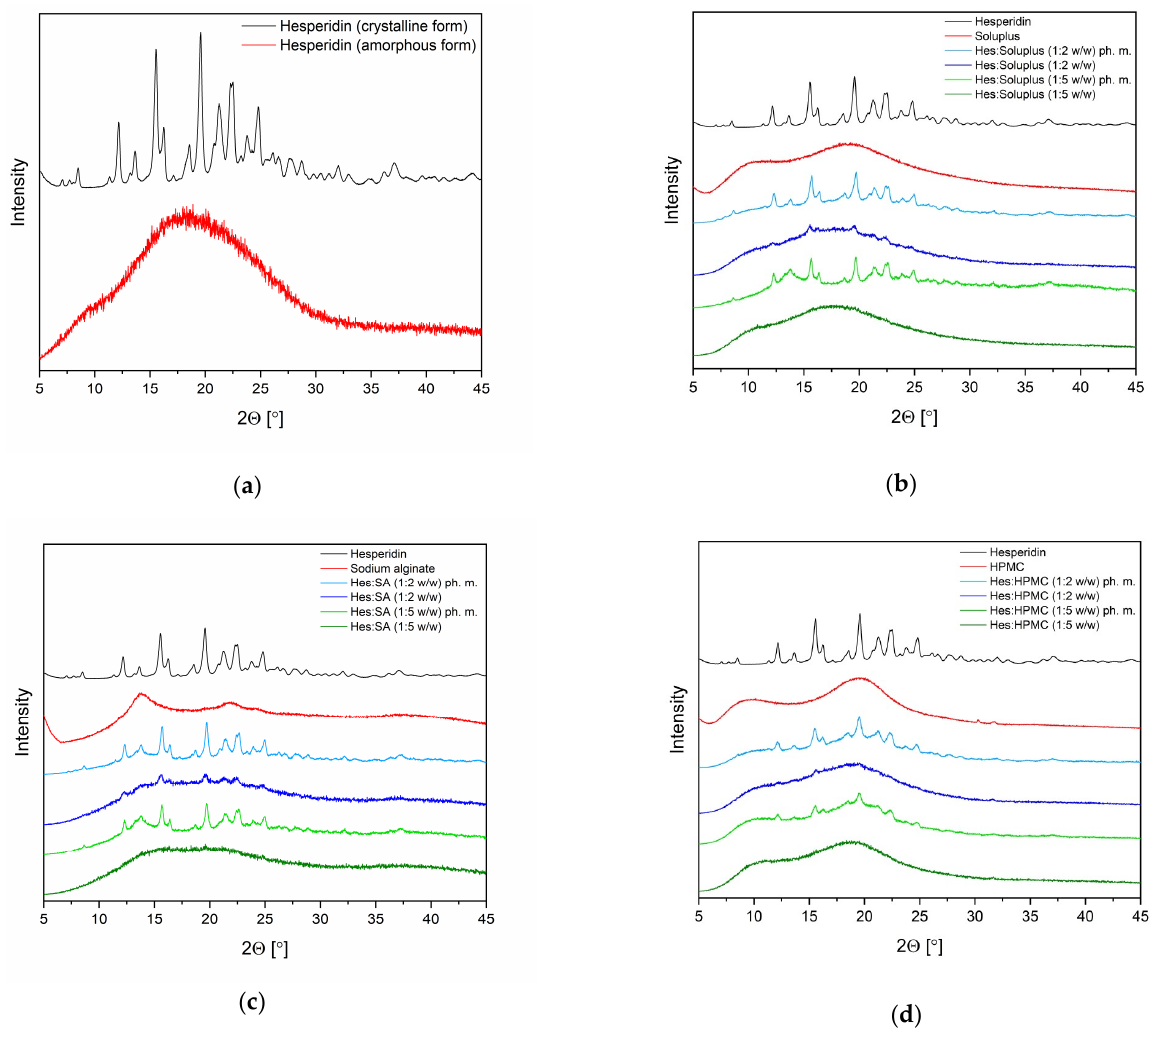
Figure 1. The X-ray powder diffraction analysis: ( a ) Hesperidin crystalline form and Hesperidin amorphous form; ( b ) Hesperidin (Hes), Soluplus ® (Sol), Hes:Sol 1:2 w/w ph. m., Hes:Sol 1:2 w/w sys- tem, Hes:Sol 1:5 w/w ph. m., Hes:Sol 1:5 w/w system; ( c ) Hesperidin, alginate sodium (SA), Hes:SA